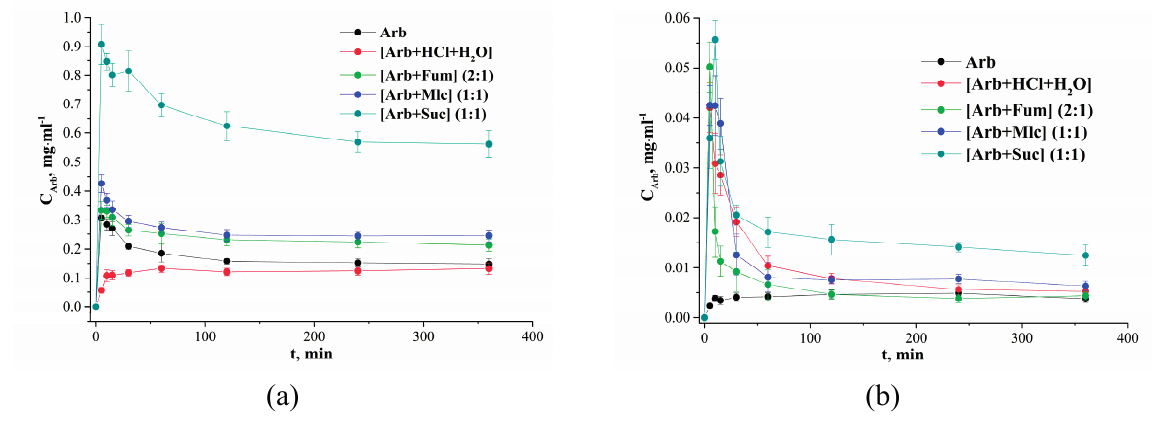
Figure 7. Dissolution profiles at 25 °C for salts, cocrystal and pure Arb in pH 1.2 ( a ) and pH 6.8 ( b